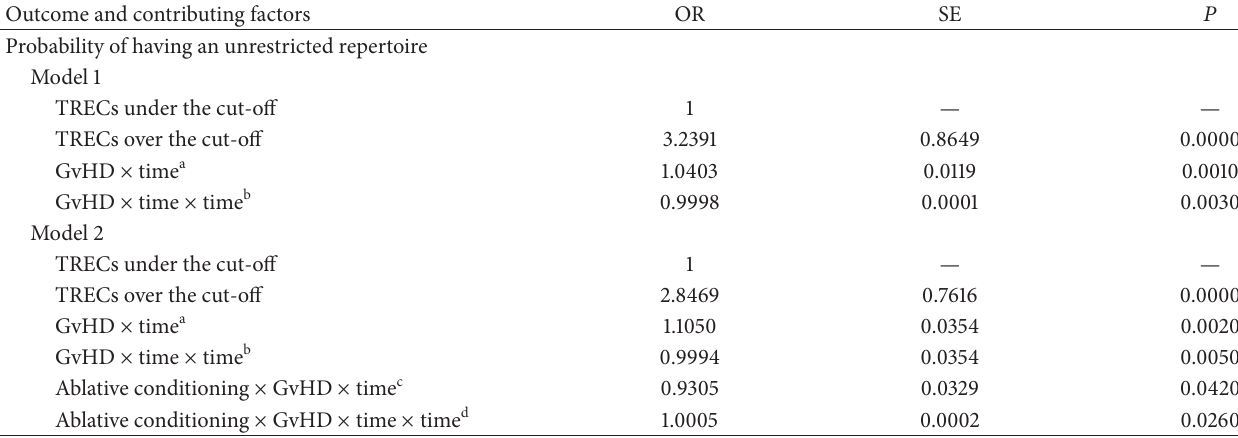
Table 4: Multivariable logistic models investigating factors affecting the probability of having an unrestricted repertoire in HSCT patients. Outcome and contributing factors OR SE 𝑃